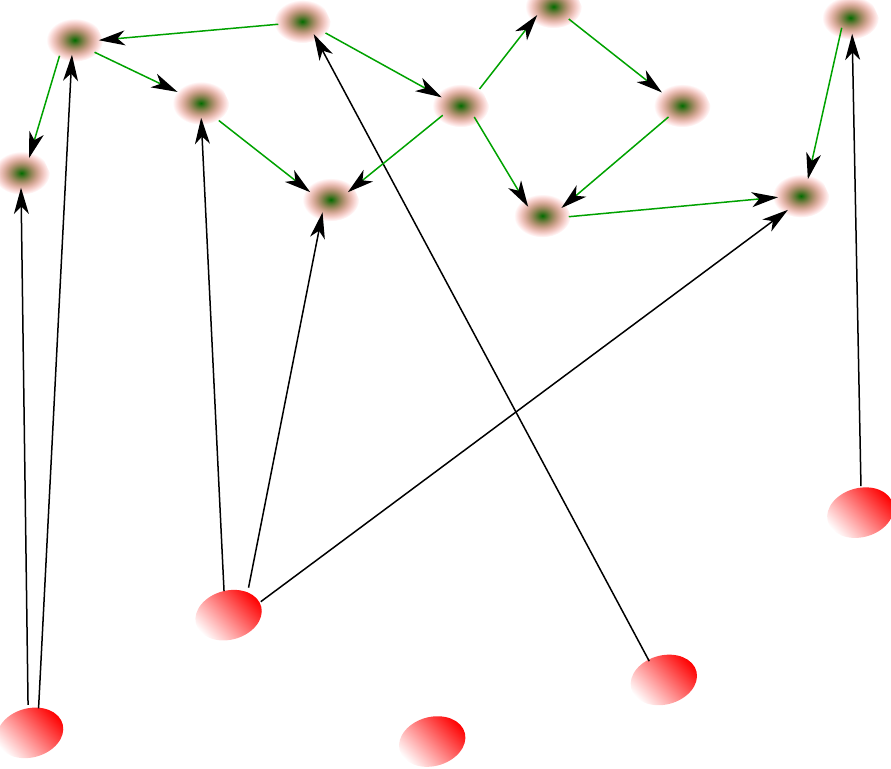
Figure 9. Two directed layers, i.e., families of nodes. The red layer sends information toward the green layer, while nodes of the last layer send information to each other. Thus, the green layer could represent the layer of miners, while the red layer could represent the layer of exchanges. In such a model, the miners are the main layer. We could easily change the configuration so that exchanges are the main layer, and the following theory also